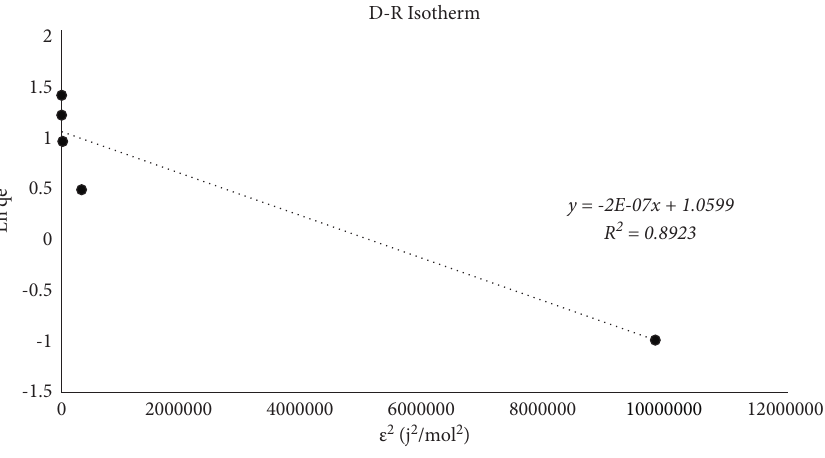
Figure 7: Ln( q 2 , D-R isotherm, MG powder. e ) to ε